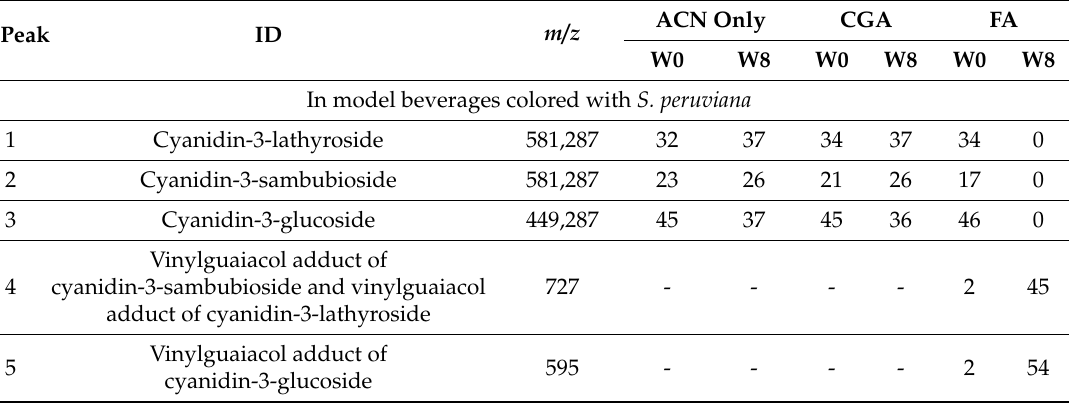
Figure 2. Anthocyanin high pressure liquid chromatography coupled with photodiode array detection (HPLC-PDA) profile of model beverages colored with anthocyanins and copigmented with ferulic acid at week 0 (W0, black line), week 4 (W4, red line) and week 8 (W8, blue line). Model beverages colored with S. peruviana (upper), S. nigra (middle), and purple carrot (lower). Table 3. HPLC-PDA with electrospray mass spectrometry characterization and peak area percentage of anthocyanin (ACN) and anthocyanin-derived pigments in model beverages colored with S. peruviana , S. nigra , and purple carrot before (W0) and after eight weeks of storage (W8). CGA: chlorogenic acid, FA: ferulic